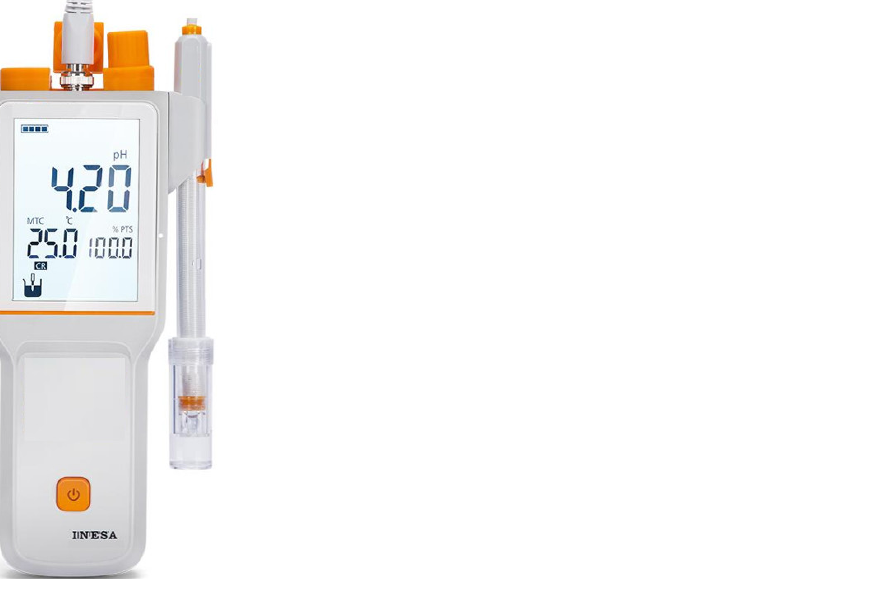
Figure 10. Portable groundwater pH value and groundwater temperature monitor.